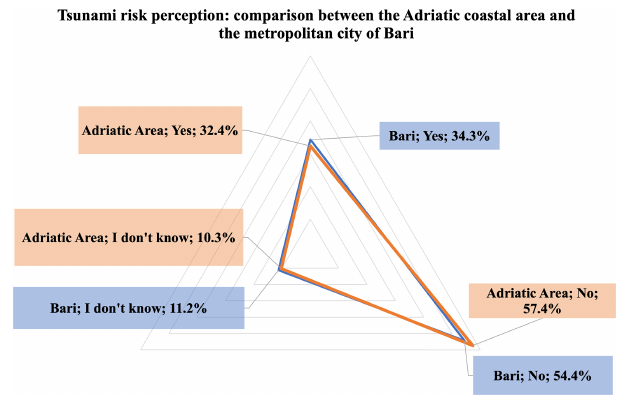
Figure 10. Tsunami risk perception (Q16): comparison between the Tyrrhenian and Ionian coastal area and the metropolitan city of Reg- gio